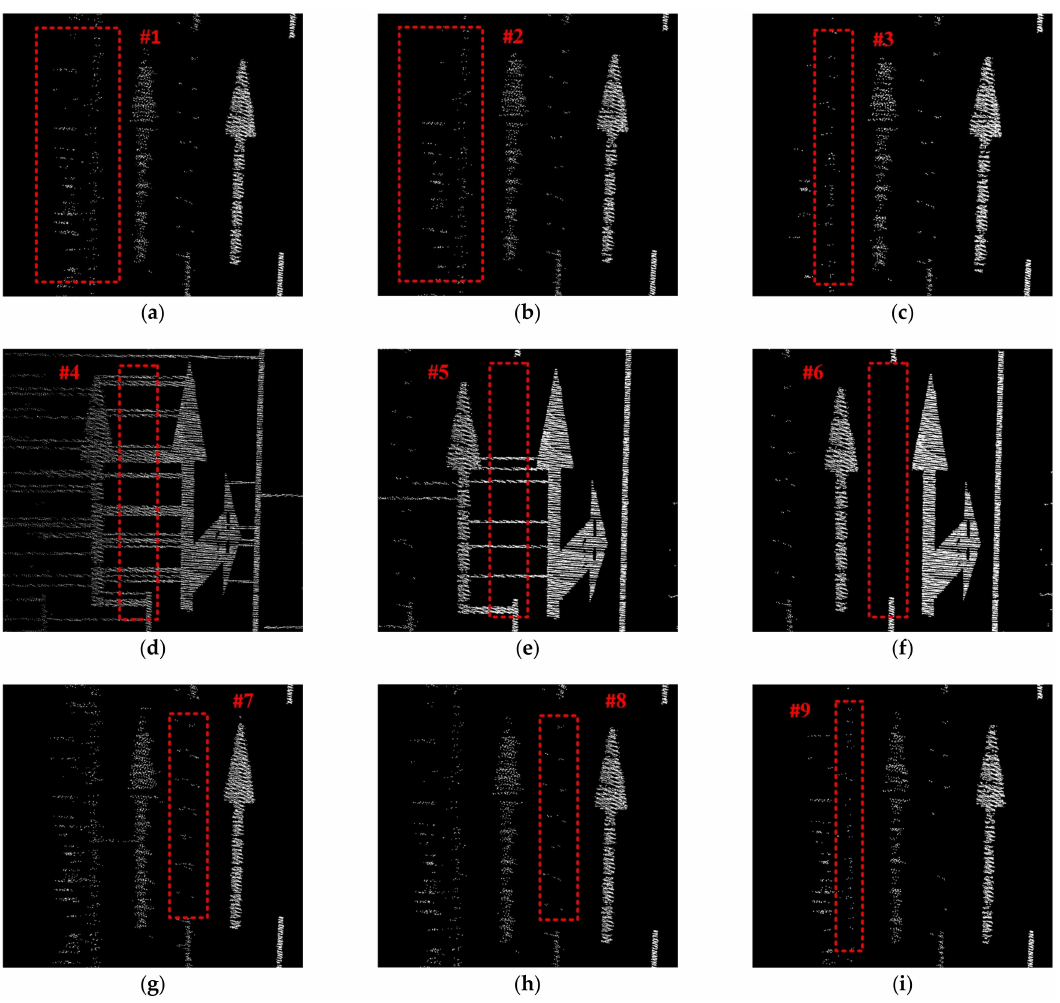
Figure 6. Road markings extracted by the marker edge constraint detector (MECD) method with di ff erent thresholds: ( a ) P th = 2; ( b ) P th = 4; ( c ) P th = 6; ( d ) N th = − 6; ( e ) N th = − 4; ( f ) N th = − 2; ( g ) I th = 8; ( h ) I th = 10; ( i ) I th = 12. P th , N th , and I th denote the positive gradient threshold, the negative gradient threshold, and the intensity